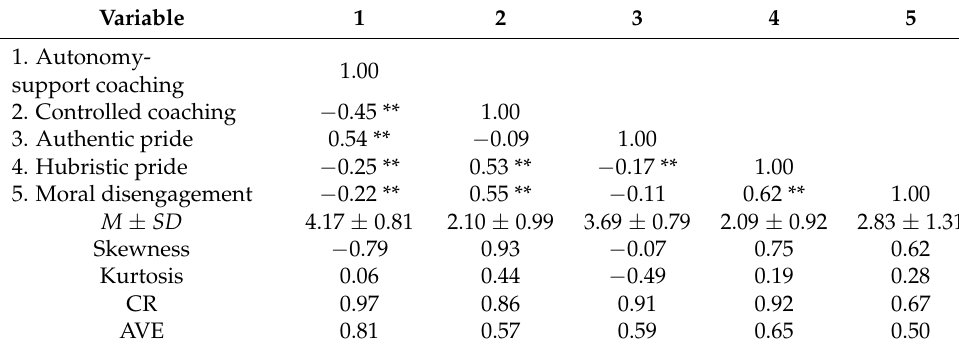
Table 1. Correlation Coefficient between Measurement Variables.